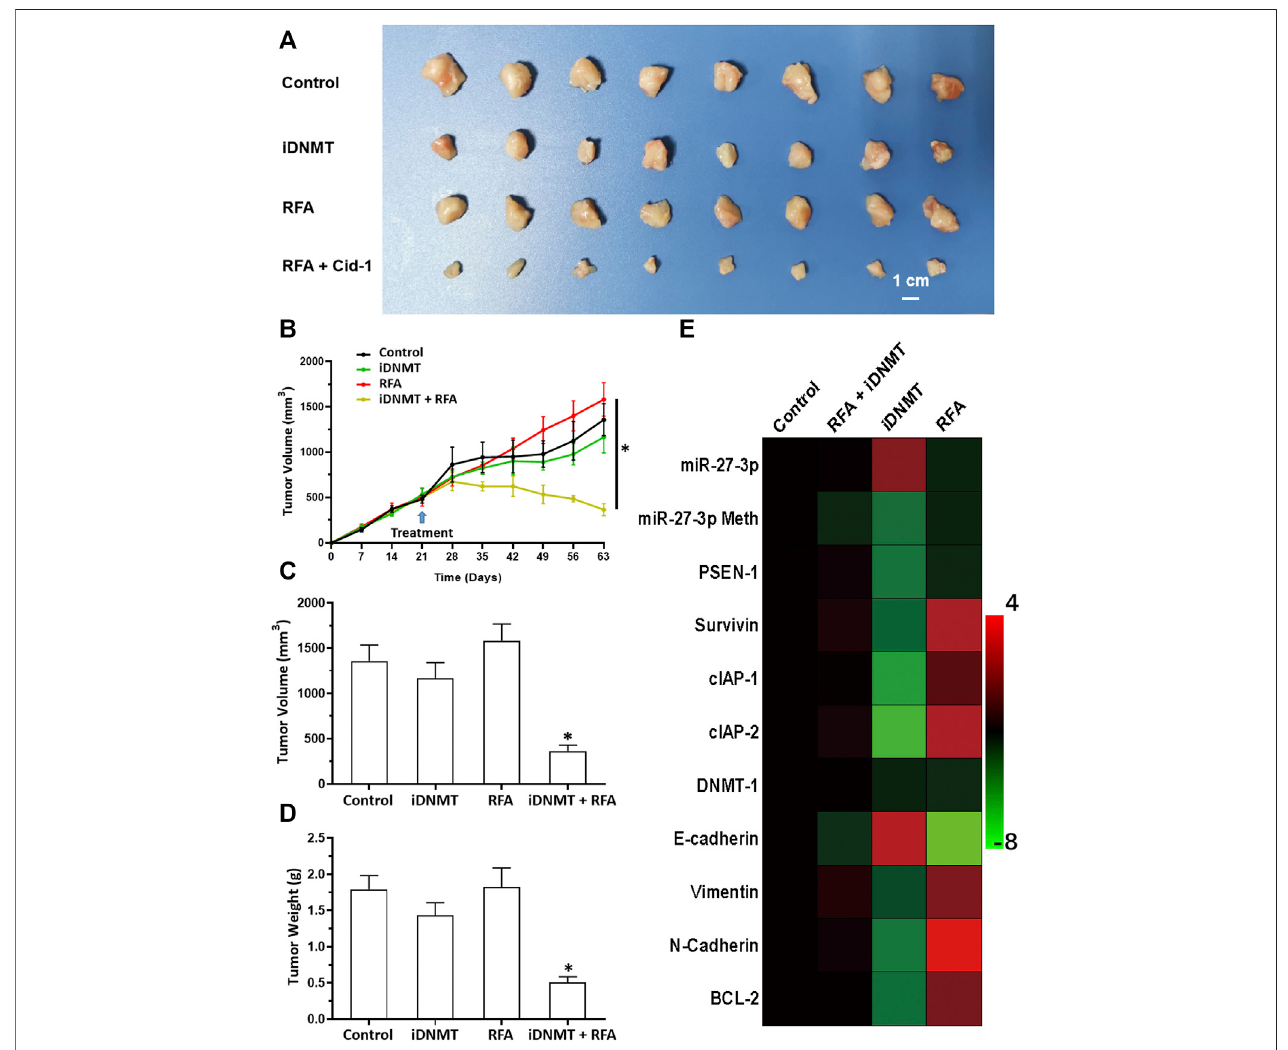
FIGURE 8 | RFA + iDNMT inhibits the subcutaneous proliferation of H226 LSCC cells in nude mice. (A) Images of tumor tissues. (B) Tumor growth curves. (C,D) Volumes and weights of tumor tissues are displayed as histograms. (E) Effect of RFA or iDNMT on the expression of Notch pathway-related factors is displayed as a heat-map. Comparison between the iDNMT group and control group. * p <